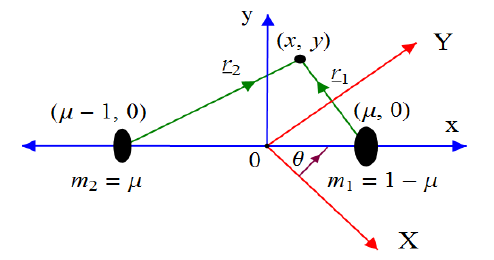
Fig. 1 Configuration of the sidereal XY and synodic xy frames of the restricted three-body